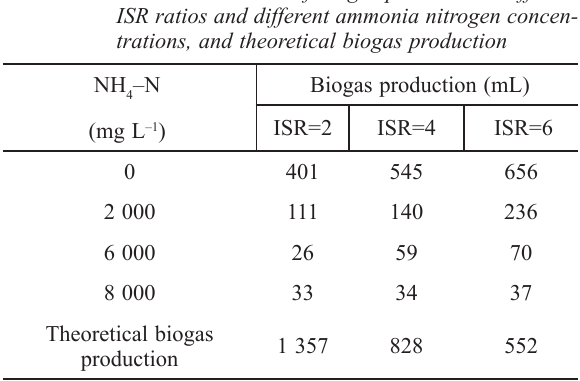
Table 2 – Maximum volumes of biogas produced at different ISR ratios and different ammonia nitrogen concen- trations, and theoretical biogas